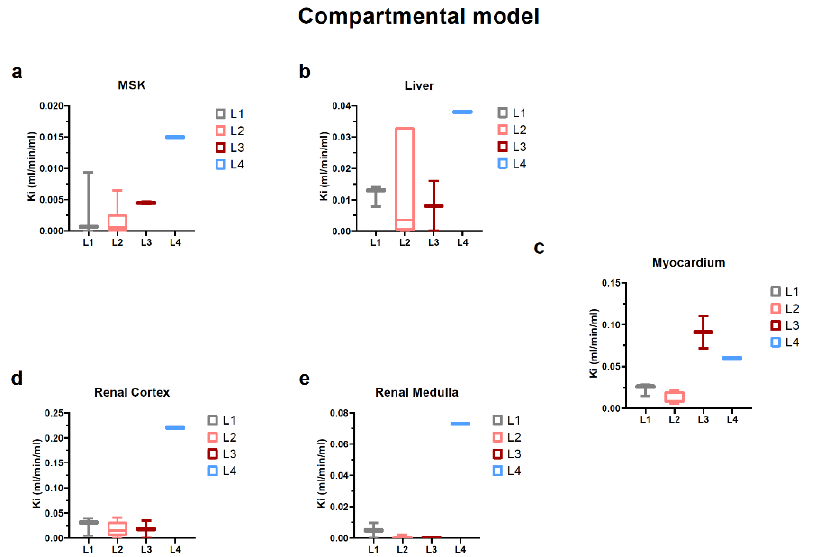
Figure 11. K i values derived from compartmental model for each target organ/region and also for internal control organs, namely skeletal muscle ( a ), liver ( b ), myocardium ( c ), renal cortex ( d ) and renal medulla ( e ).